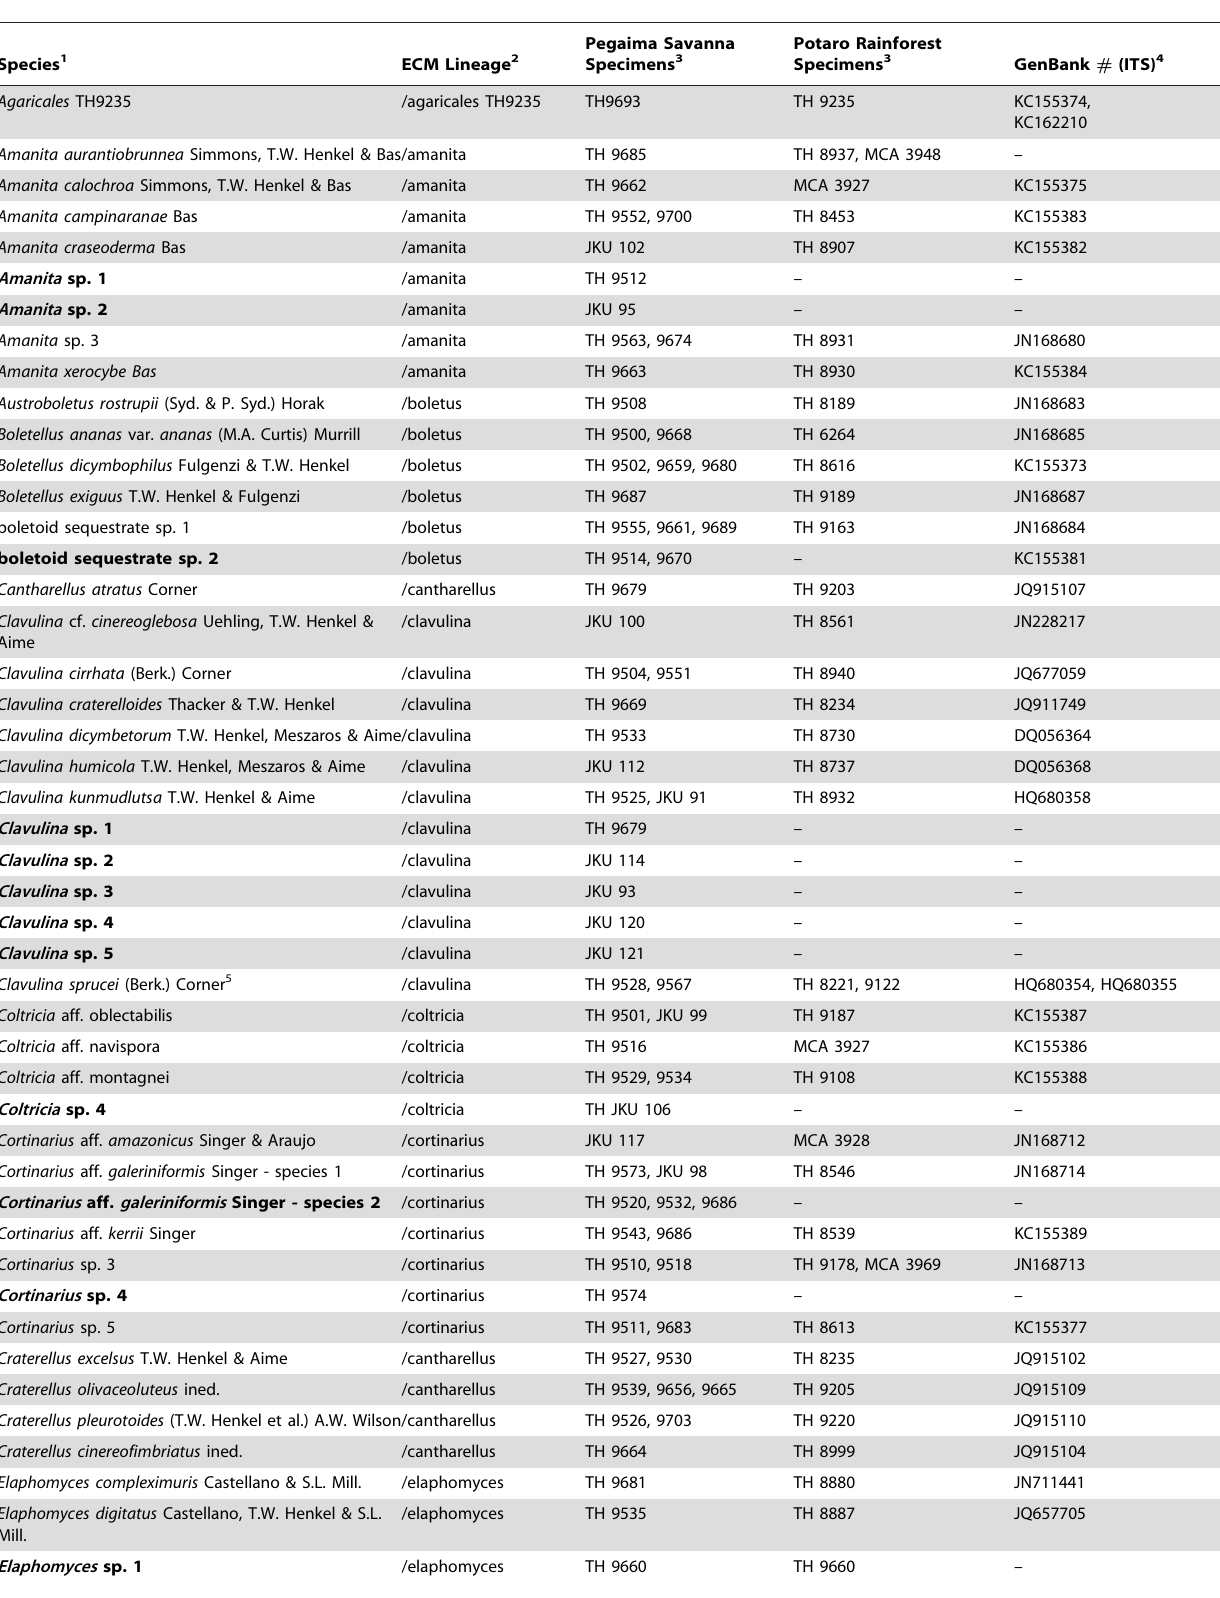
Table 2. Ectomycorrhizal fungal taxa recovered as sporocarps in savanna-fringing forests dominated by host trees Pakaraimaea dipterocarpacea and Dicymbe jenmanii at the Pegaima site in the Upper Mazaruni Basin during